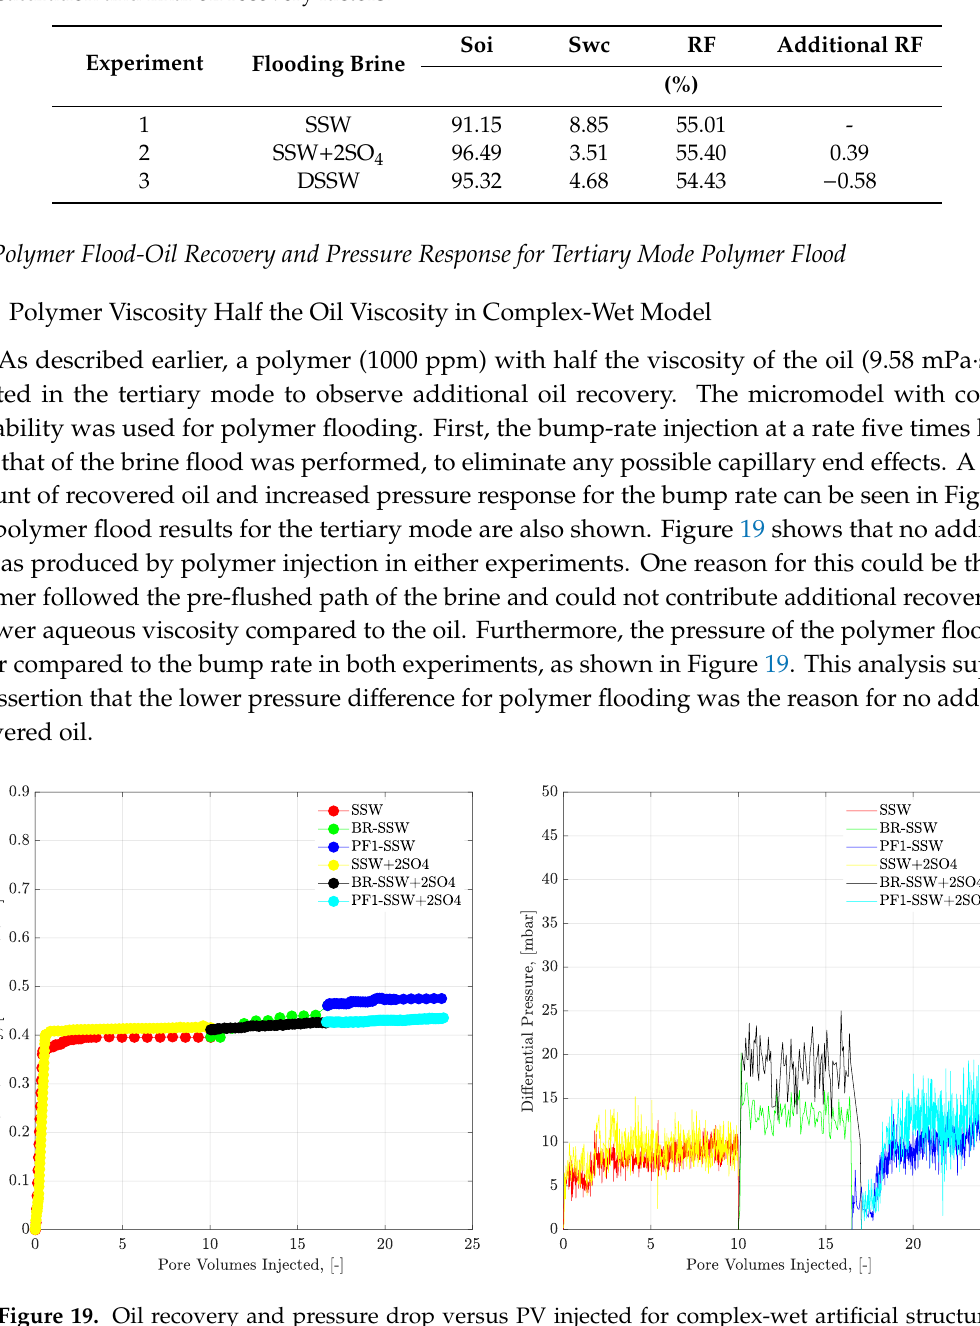
Figure 19. Oil recovery and pressure drop versus PV injected for complex-wet artificial structure micromodel. Polymer (half to the oil viscosity) flooding in tertiary mode after the brine flood in secondary mode.